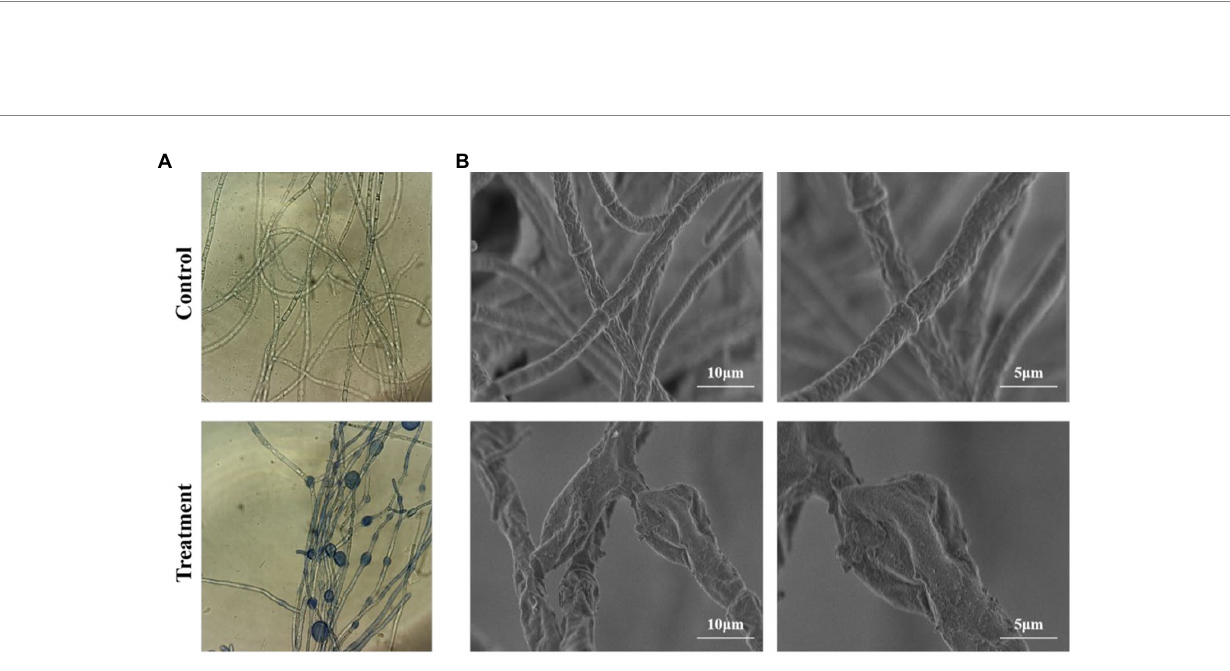
FIGURE 3 Effect of cell-free culture filtrate on the morphology of Bipolaris sorokiniana . (A) Mycelium morphology under optical microscope (×20), blue color represents dead fungi cells. (B) Mycelium ultrastructure under scanning electron microscope, scale bars = 10 and 5 μ m. Control: untreated control group; Treatment: treated with cell-free culture filtrate produced by Bacillus amyloliquefaciens